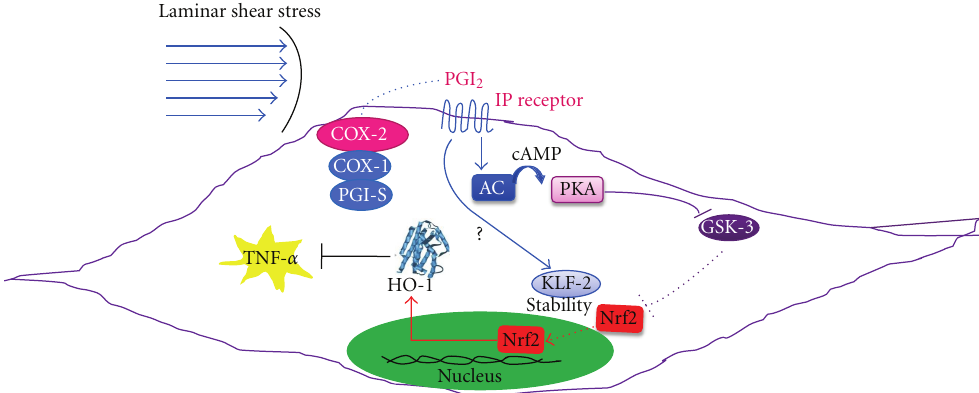
Figure 2: Postulated molecular mechanism involved in the induction of HO-1 by COX-2-dependent PGI 2 , in endothelial cells exposed to steady laminar shear stress (LSS). In endothelial cells exposed to uniform LSS (characteristically associated with atherosclerotic lesion- protected areas), COX-2 is overexpressed [11]. PGI 2 , mainly produced by the combined activity of COX-2 and PGI 2 -synthase (PGIS), interacts with its specific receptor, IP [14]. This interaction may lead to the activation of adenylate cyclase (AC), causing an increase of intracellular levels of cyclic AMP (cAMP) and subsequently to the activation of protein kinase A (PKA) [14]. PKA may phosphorylate glycogen synthase kinase(GSK)-3 [15], causing its inactivation and the loss of the capacity to phosphorylate nuclear factor E2-related factor 2 (Nrf2) [16]. Reduced phosphorylation of Nrf2 causes its stabilization and translocation into the nucleus, where it promotes the transcription of antioxidant and phase II genes, including HO-1 [11, 17]. In addition to Nrf2, Kruppel-like factor(KLF)-2 is increased in endothelial cells exposed to LSS [18]. KLF2 enhances antioxidant activity of Nrf2 by increasing its nuclear localization and activation [19]. The synergistic activity of these two transcription factors forms a major contribution to the shear-stress-elicited transcriptome in endothelial cells. The overexpression of HO-1 in endothelial cells by LSS exerts an anti-inflammatory action through its capacity to inhibit the biosynthesis and release of TNF- α